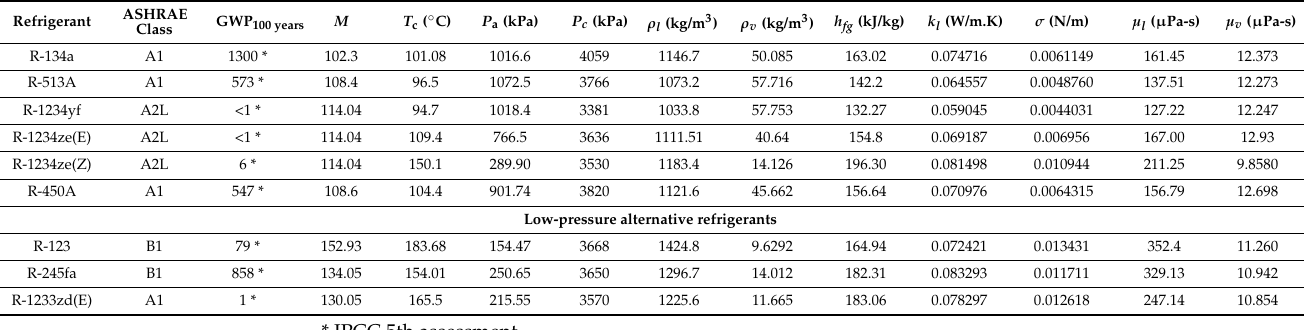
Table 1. At 40 ◦ C, the transport and thermodynamic properties of LGWP refrigerants alternative to R-134a [3].